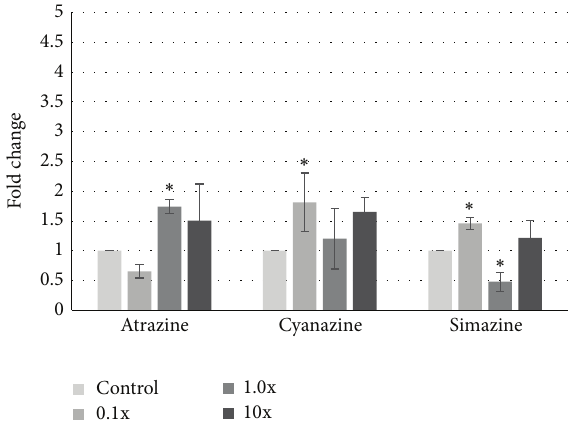
Figure 3: Change in GPR30 expression in MDA-MB-231 cells after atrazine exposure. MDA-MB-231 human breast cancer cells were treated with 0.1- to 10-fold concentrations of the EPA safe levels of atrazine, cyanazine, or simazine for 24 hours. mRNA was harvested, cDNA was synthesized, and specific amplicons were prepared using primers to GAPDH (reference gene) or GPR30. Resulting fold changes in expression ± standard deviation are shown, with the vehicle control set at 1. Statistically significant changes in induction compared to the control are indicated ( ∗ 𝑝 < 0.05 ).